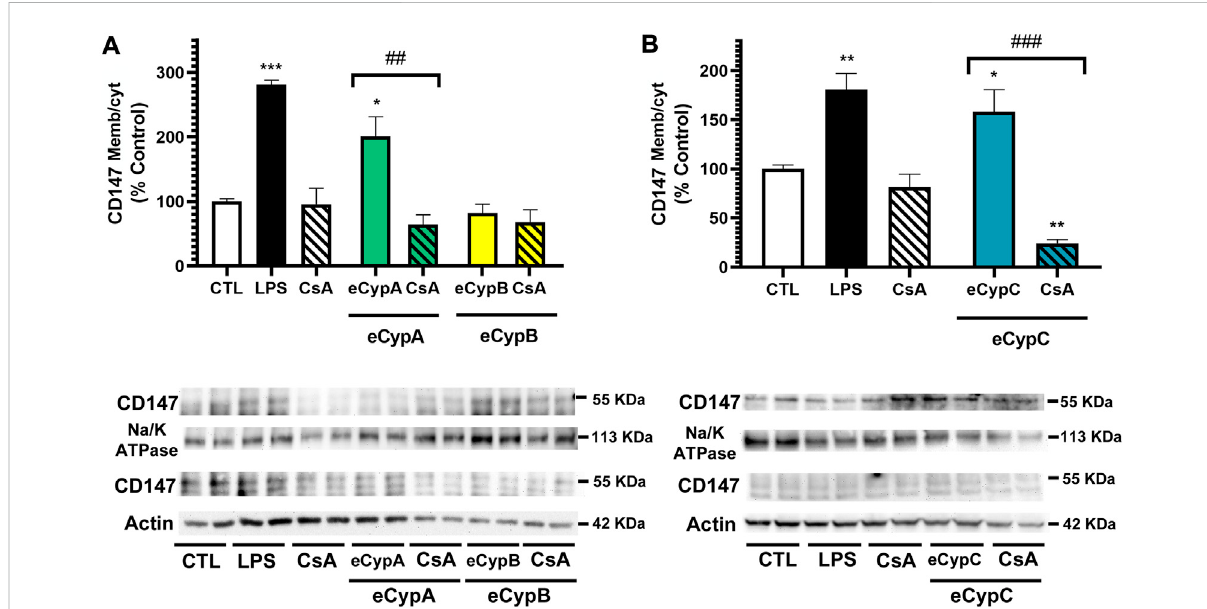
FIGURE 3 Analysis of CD147 expression by western blot. (A) Receptor expression after addition of eCypA and eCypB, (B) CD147 levels after eCypC treatment.MS1cellsweretreatedwitheCypsat0.5 μ g/mlfor24 handCD147expressionincytosolicandmembranousfractionswasevaluated.CsA at 0.2 μ M was added 1 h before treatment with 0.5 μ g/ml eCyps. LPS at 1 μ g/ml was used as positive control. Protein band expression was normalized by Na-K ATPase and actin levels in membranous and cytosolic fractions, respectively. The quanti fi ed bands are indicated by their molecular weight. Results are mean ± SEM of three replicates performed by duplicate, expressed as ratio between membranous and cytosolic expression. Statistical differences were determined by one way ANOVA and Tukey ’ s tests (* p < 0.05, ** p < 0.01, *** p < 0.001 compared to